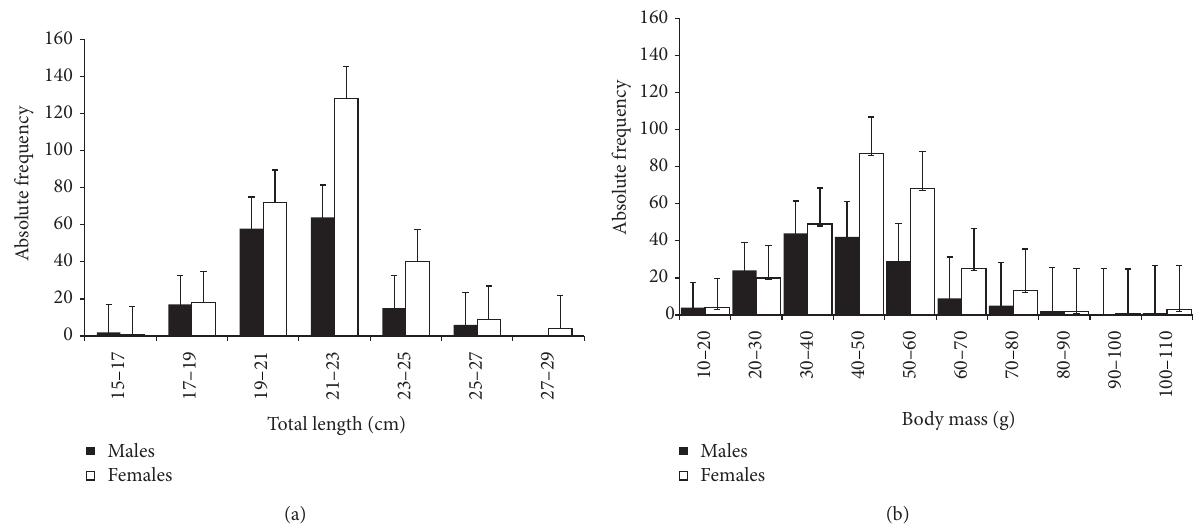
Figure 1: Mean monthly distribution according to class intervals of (a) total body length; (b) body mass of H. brasiliensis ( 𝑁 males = 160; 𝑁 females = 272).